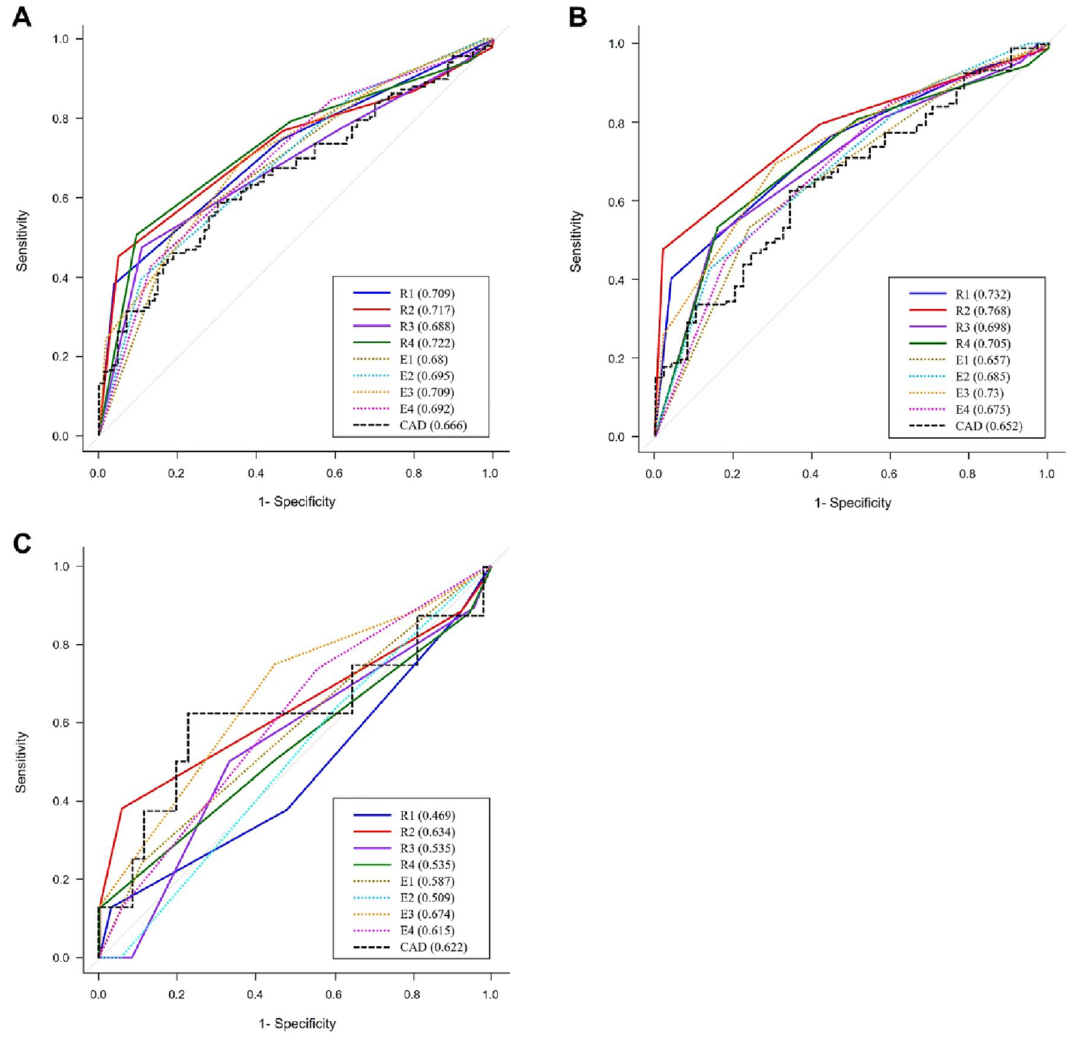
Figure 1. Comparing diagnostic performances between the 8 physicians and CNN using the receiver operating characteristic analysis for the atypia of undetermined significance (AUS)/follicular lesion of undetermined significance (FLUS, A ), only AUS ( B ), and only FLUS ( C ) groups. Data in parentheses are the AUC results of each physician or CNN. CNN deep convolutional neural network, AUS atypia of undetermined significance, FLUS follicular lesion of undetermined significance, R radiologist, E